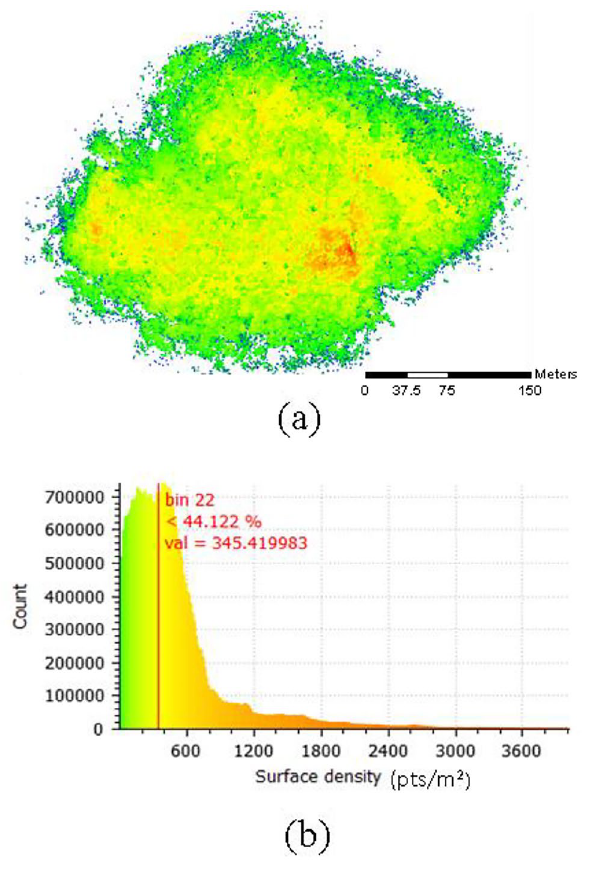
Fig. 3 Point cloud obtained through UAV-LiDAR